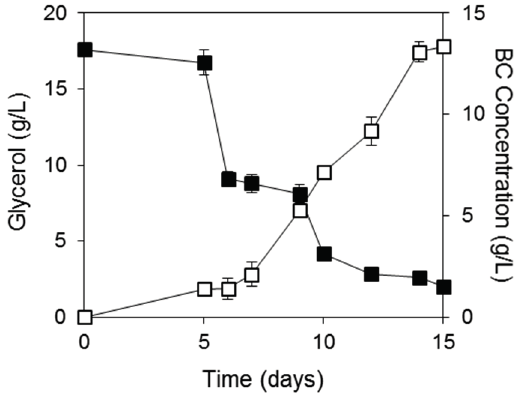
Figure 3. Crude glycerol consumption and BC production using SFM hydrolysates